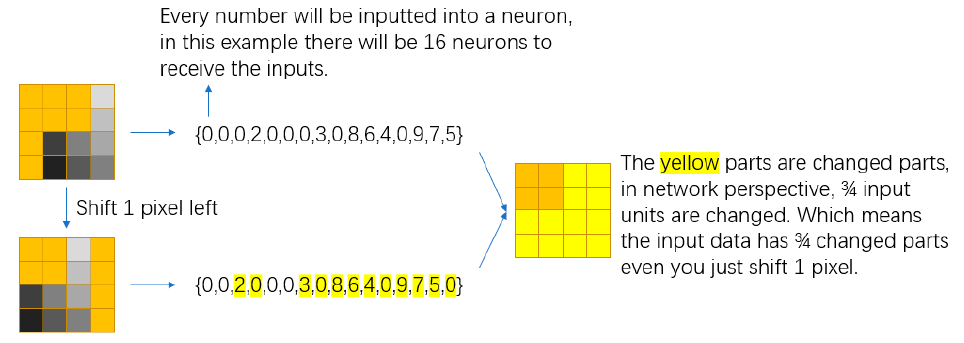
Figure 9. The input comparison of original data and shift 1 pixel left.